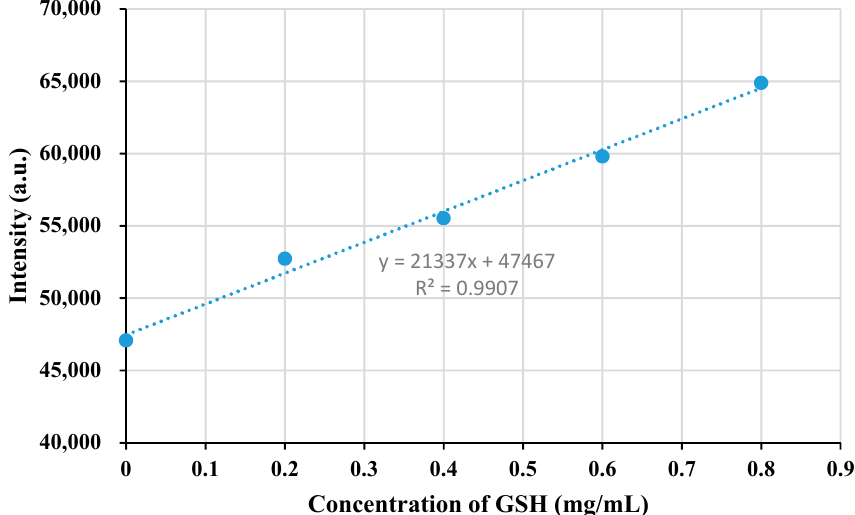
Figure 9. ( a ) Photoluminescence spectra of the LaF 3 :Yb 3 + 0.20 , Er 3 + 0.02 @LaF 3 :Yb 3 + 0.20 core / shell UCNPs under di ff erent Hg 2 + concentrations and ( b ) linear relationship between the emission intensity and Hg 2 + concentration. ( c ) Photoluminescence spectra of the UCNPs / Hg 2 + system under the increasing glutathione (GSH) concentrations and ( d ) linear relationship between the emission intensity and GSH concentration.